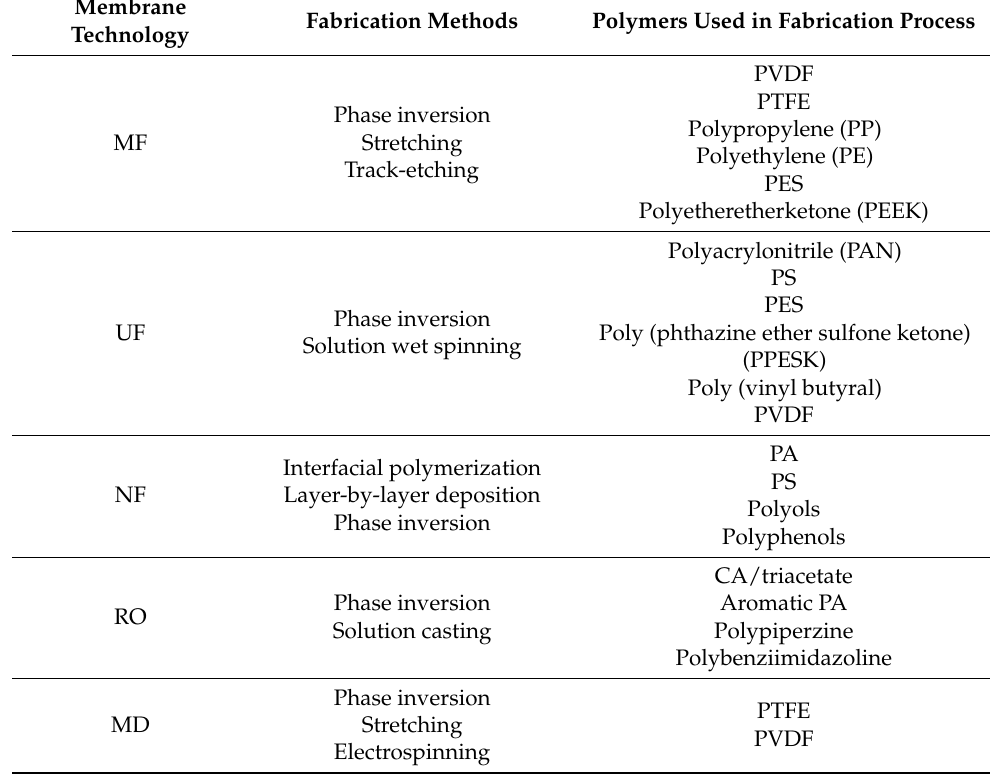
Table 14. Examples of fabrication methods and polymers used for the preparation of polymeric membranes widely used in water and wastewater treatments [266]. Reproduced with permission from Lalia, B.S.; Kochkodan, V.; Hashaikeh, R.; Hilal, N, Desalination; published by Elsevier, 2013.